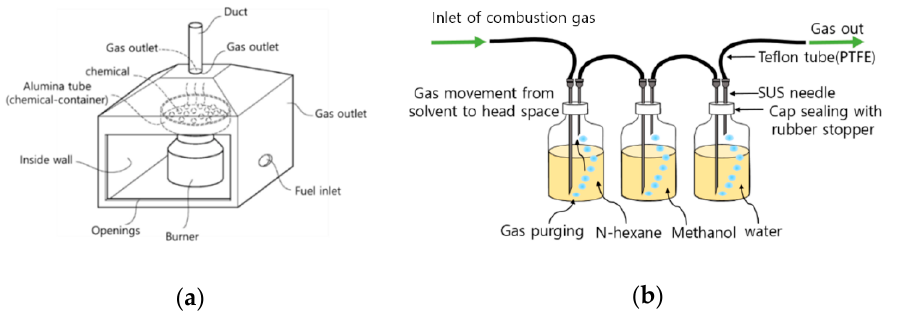
Figure 1. Schematic diagram of apparatus for combustion experiment (instruments and apparatus for fire simulation batch test) shows ( a ) iron chamber for chemical combustion and ( b ) arrangement of three solvents that can dissolve combustion products generated in fire simulation batch test.